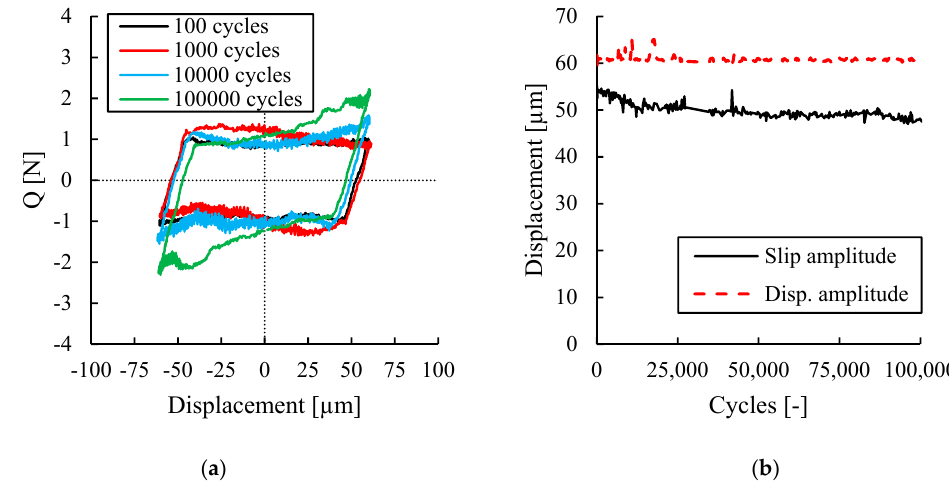
Figure 8. ( a ) Evolution of the fretting loop at different cycles; ( b ) Evolution of the slip and displacement